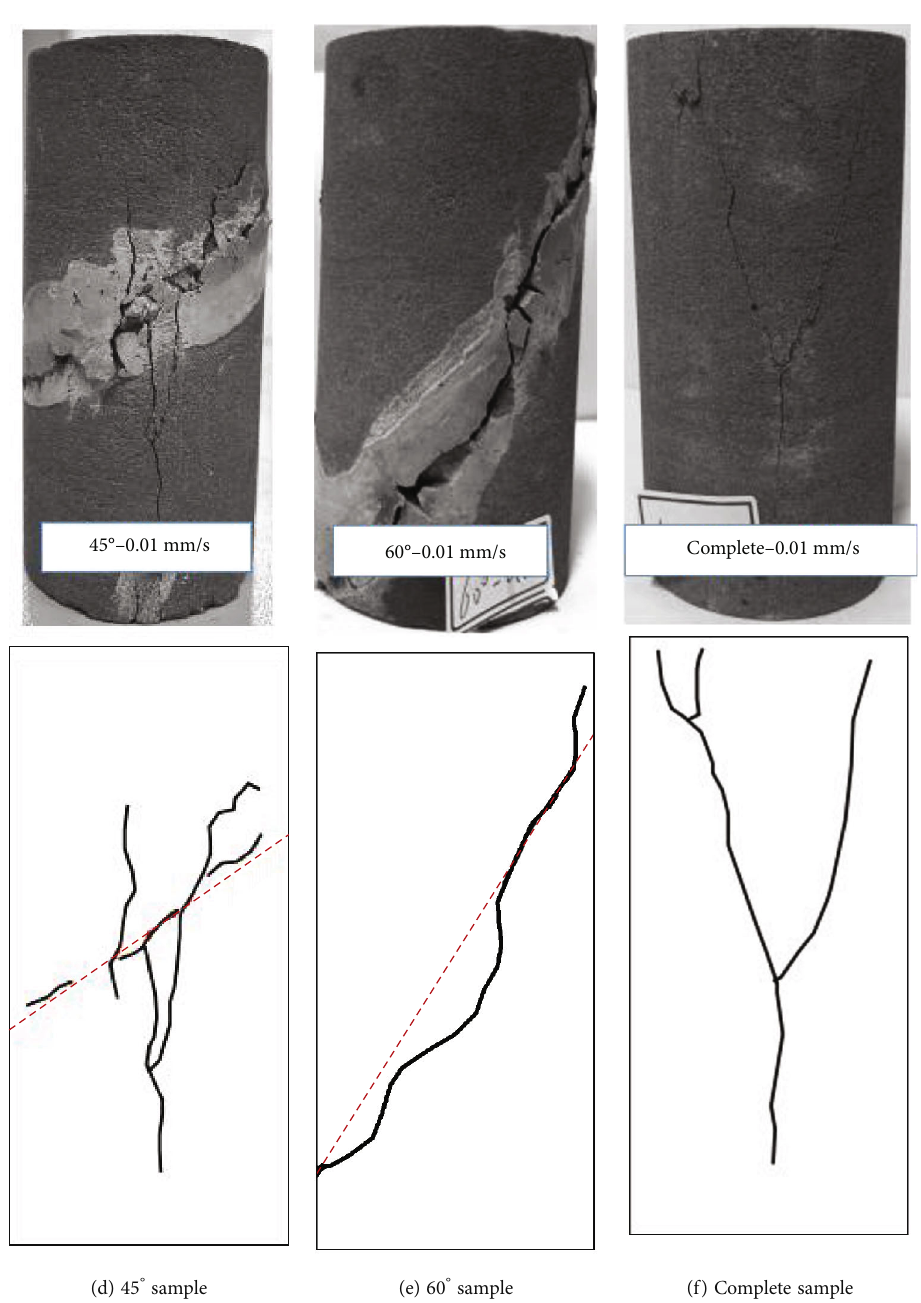
Figure 8: Macroscopic crack damage of grouted body under di ff erent crack inclination